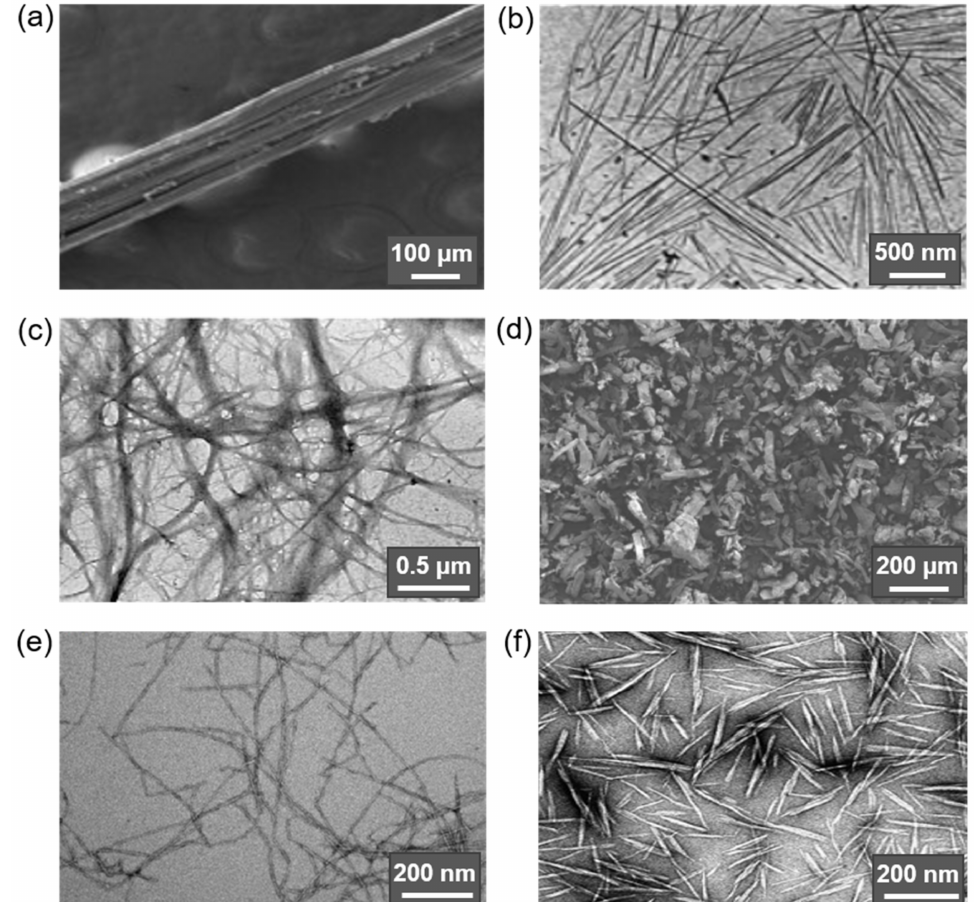
Figure 2. Overview of cellulose micro- and nanomaterials commonly used as fillers to prepare composite materials. Electron micrographs of ( a ) sisal fiber (scanning electron microscopy (SEM), reproduced from [62] under the terms of the Creative Commons CC BY license), ( b ) tunicate whiskers (transmission electron microscopy (TEM), reproduced from [63] with permission of American Chemi- cal Society), ( c ) sugar beet CMF (TEM, reproduced from [64] with permission of Elsevier), ( d ) CMC, commercial (SEM, reproduced from [65] with permission of John Wiley & Sons, Inc), ( e ) wood CNF (TEM, reproduced from [66] with permission of American Chemical Society), ( f ) CNC from ramie fibers (TEM, reproduced from [67] under the terms of the Creative Commons CC BY